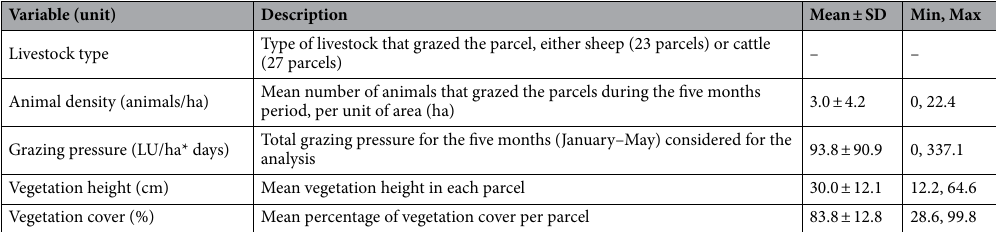
Table 1. Explanatory variables used to model the effect of grazing regime on birds, and respective descriptive statistics for the 50 sampled parcels. SD standard deviation, Min Minimum, Max Maximum.